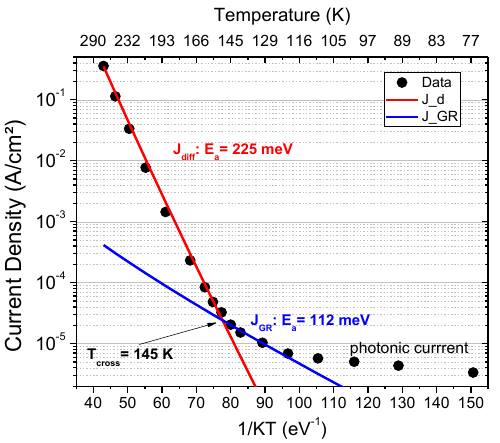
− 350 mV. Photonics 2020 , 7 , x FOR PEER REVIEW